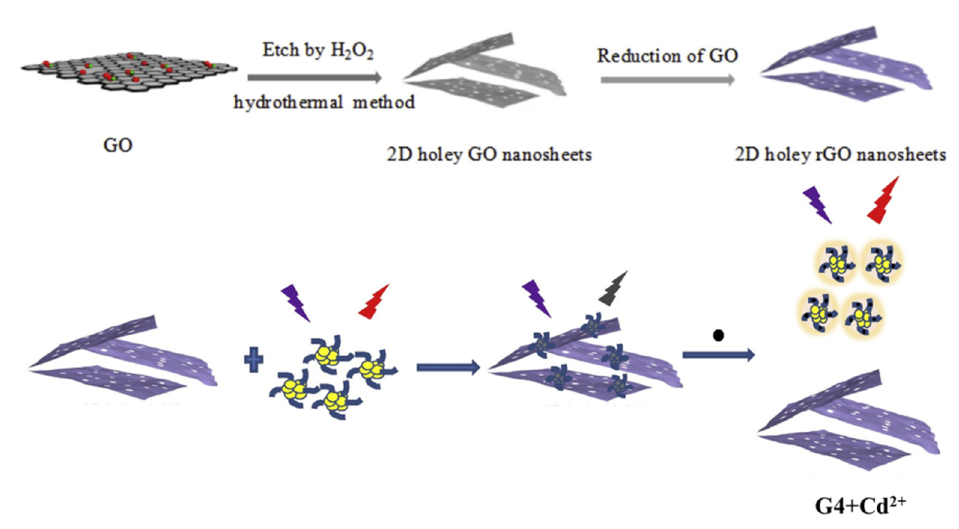
Figure 6. Preparation of HRGO and graphical representation of Cd 2+ ion sensing using GSH-AuNCs and HRGO ( G4 ). Reprinted from [57] with permission from Elsevier.